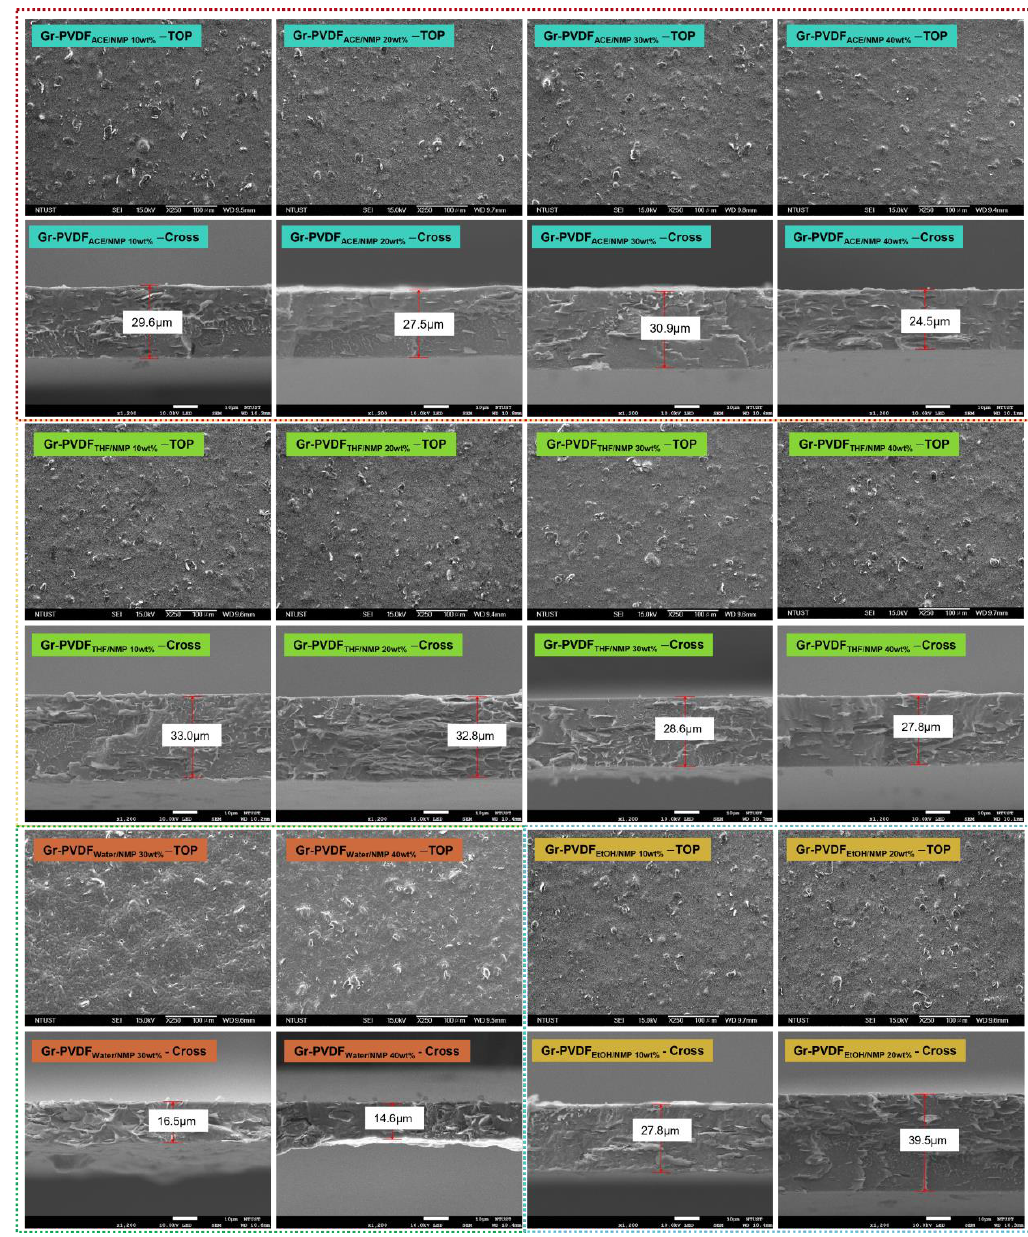
Figure 5. SEM of cross-section and the top surface of the composite film Gr-PVDF with different solvents (acetone/NMP, THF/NMP, water/NMP, and EtOH/NMP): the top surface with the magni- fication × 2500 and the part cross-section with the magnification × 1200.